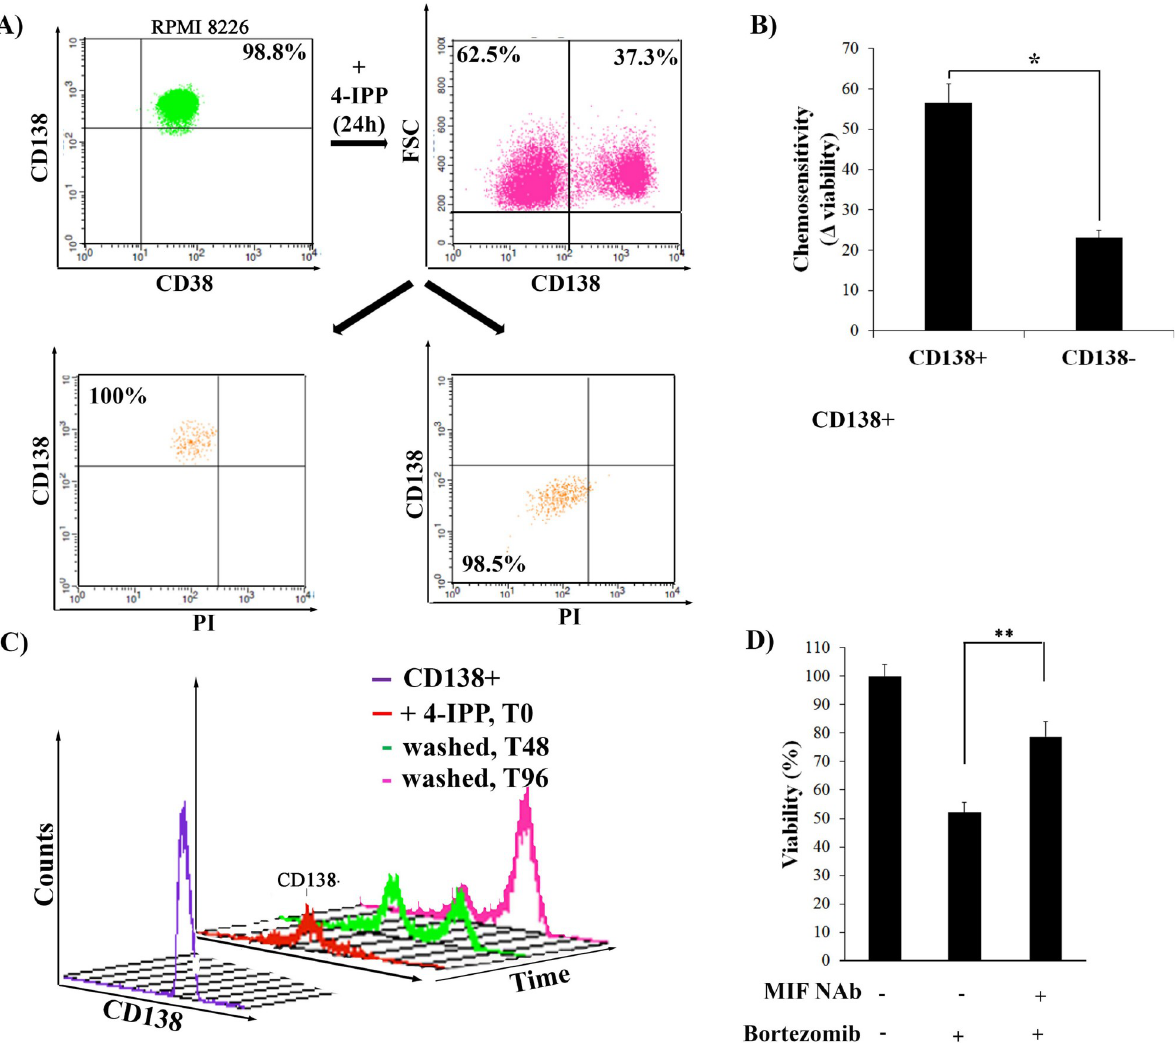
Fig 5. 4-IPP dedifferentiated RPMI 8226 CD138- cells are chemoresistant. A) Sorted CD138+ cells were treated with 60 μ M 4-IPP for 24 h. Cells were stained for CD138 and PI and sorted to recover viable (PI negative) CD138+ and CD138- cells. B) These sorted cells were plated and treated with Bortezomib for 24 h and chemosensitivity was measured as the difference in viability before and after treatment by trypan blue exclusion. � p < 0.01 C) Sorted CD138+ cells were treated with 60 μ M 4-IPP for 24 h. 4-IPP was then washed out and cells were re-plated, harvested at different timepoints, and analyzed for CD138 expression. Purple line is CD138 content at time of plating, demonstrating purity of the initially plated population. Red line is CD138 content in cells treated with 4-IPP for 24 h. CD138 expression measured at 48 (green) and 96 h (pink) post 4-IPP wash out. D) Sorted CD138+ cells were plated and untreated (lane 1), treated with Bortezomib. (lane 2), or treated + MIF Nab and Bortezomib for 24 h (lane 3). The MTT assay used to assess viability of the different populations, mean absorbance values of untreated cells (lane 1) was set to 100 (N = 3). �� p < 0.001 t-test with Satterthwaite corrections to allow for possible unequal variances. Error bars, mean ±